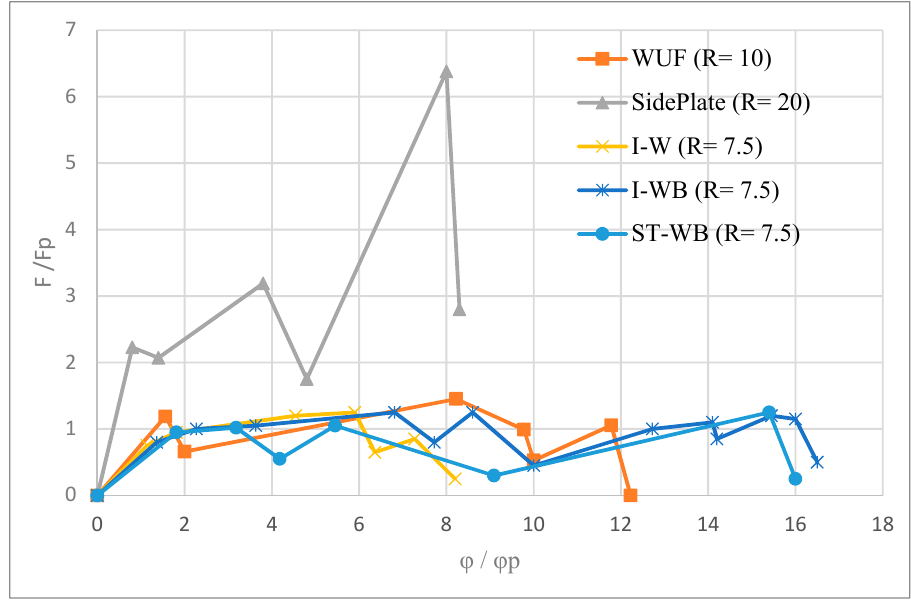
Figure 6. Normalized pushdown resistance against normalized rotation of fully rigid